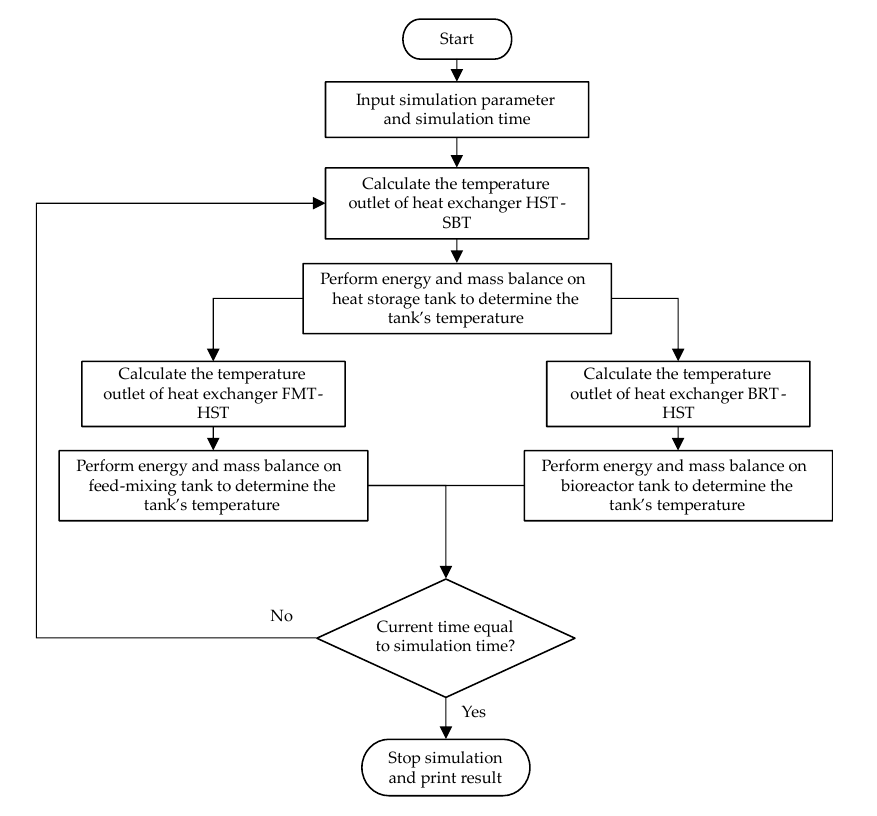
Figure 13. Simulation flowchart for the validation model.